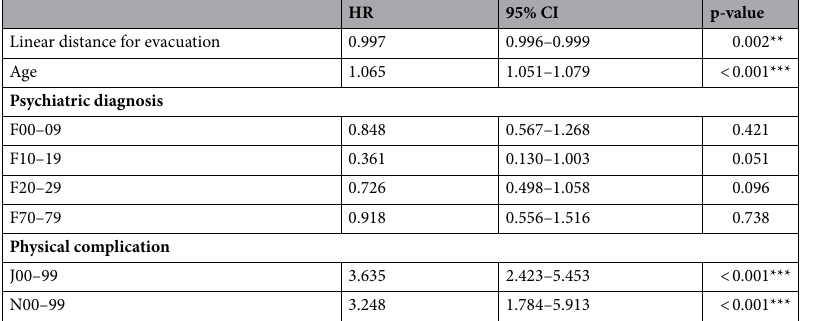
Table 3. Results of the multivariable analysis for the association between mortality and characteristics of participants. The Cox proportional hazards regression model was adopted for the analysis. Mortality rates of participants with each psychiatric diagnosis or physical complication were compared with those of patients unaffected by any disease. HR: hazard ratio, CI: confidence interval. * p < 0.05, ** p < 0.005, *** p <